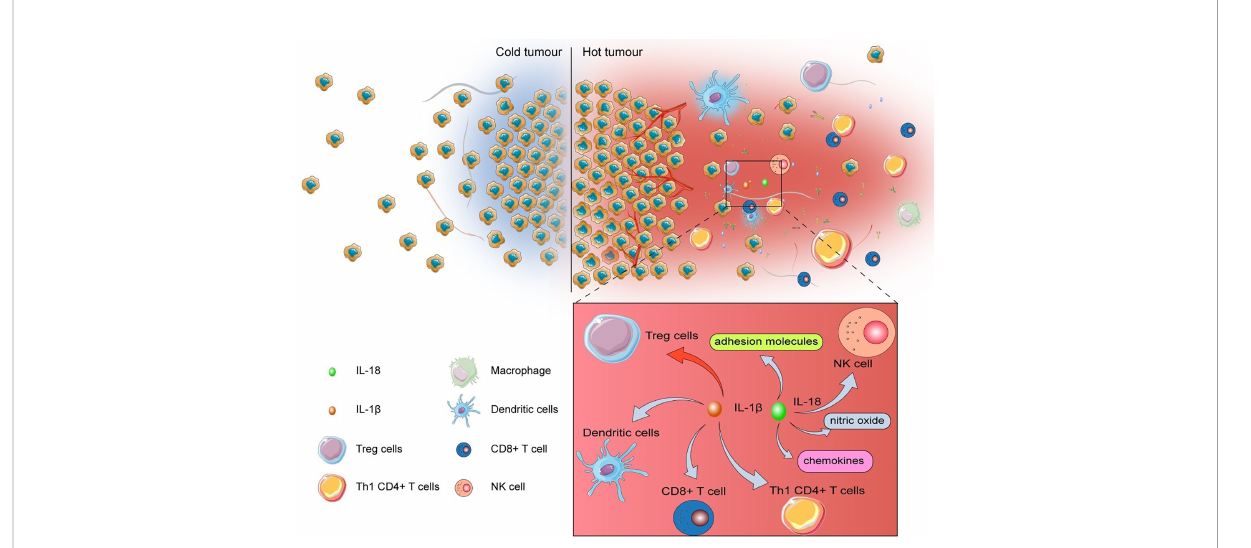
FIGURE 2 The in fl uence of pyroptosis on TME.After being released into TME, IL-1 b escalates the maturation of dendritic cells (DCs), activates antigen- speci fi c cytotoxic CD8+ T cells, recruits Th1 CD4+ T cells, but suppresses the differentiation of immunosuppressive Treg cells. IL-18 polarizes Th1 cells, recruits and activates natural killer (NK) cells, and produces adhesion molecules, chemokine, and nitric